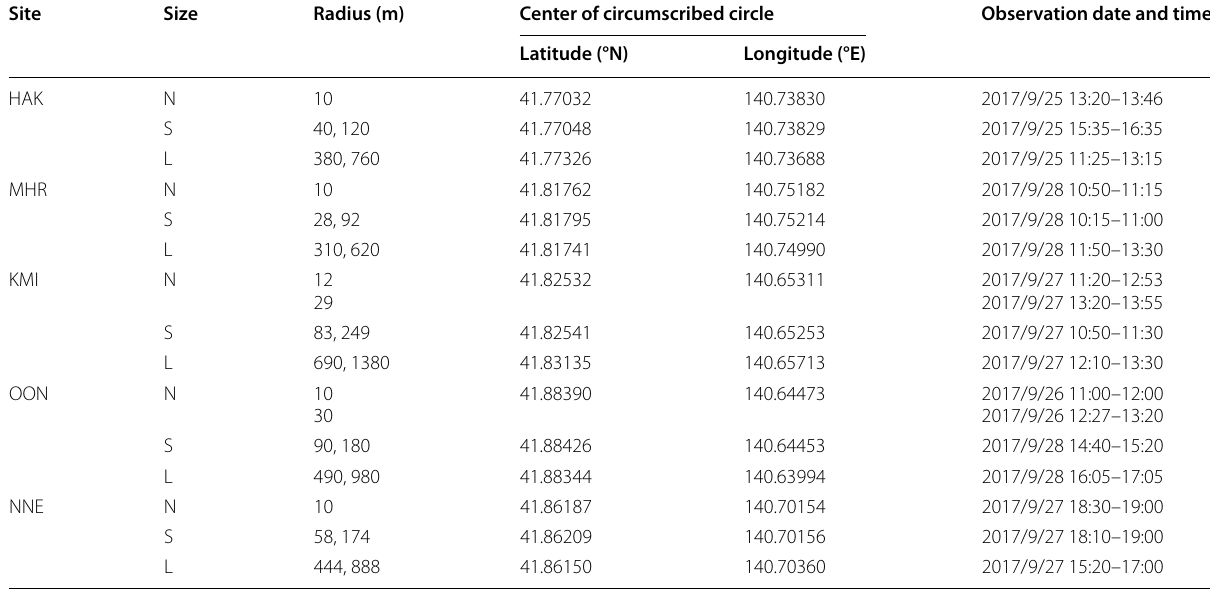
Table 1 Summary of the microtremor array observations in the Hakodate Plain